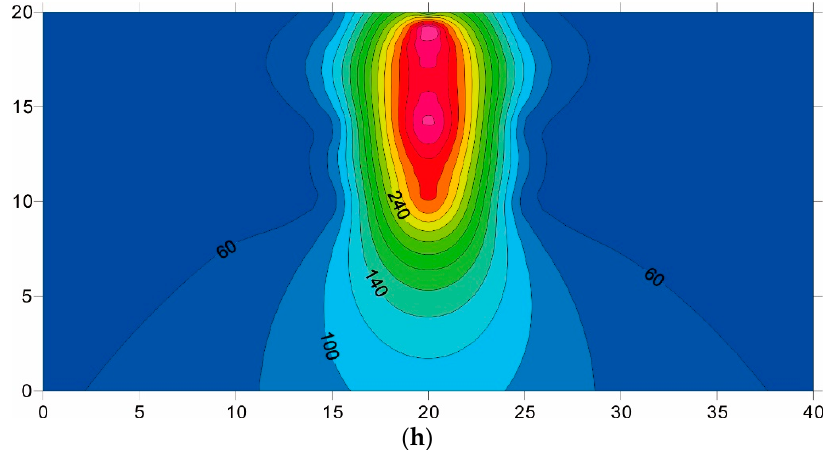
Figure 6. Vertical temperature profile of the oil layer in each cycle. ( a ) 1st cycle; ( b ) 2nd cycle; ( c ) 3rd